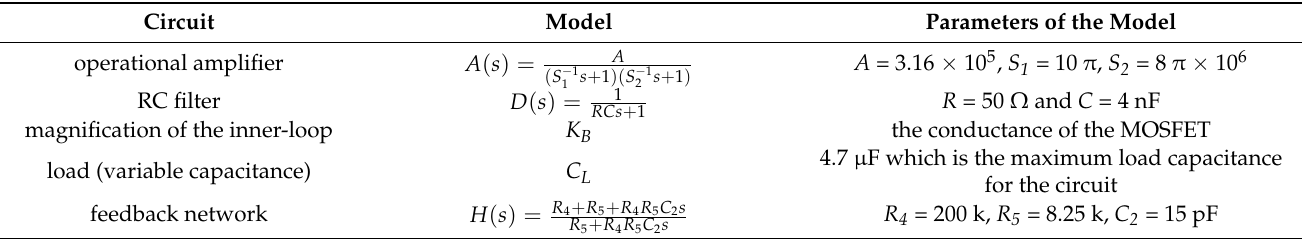
Table 1. The parameters of the control block